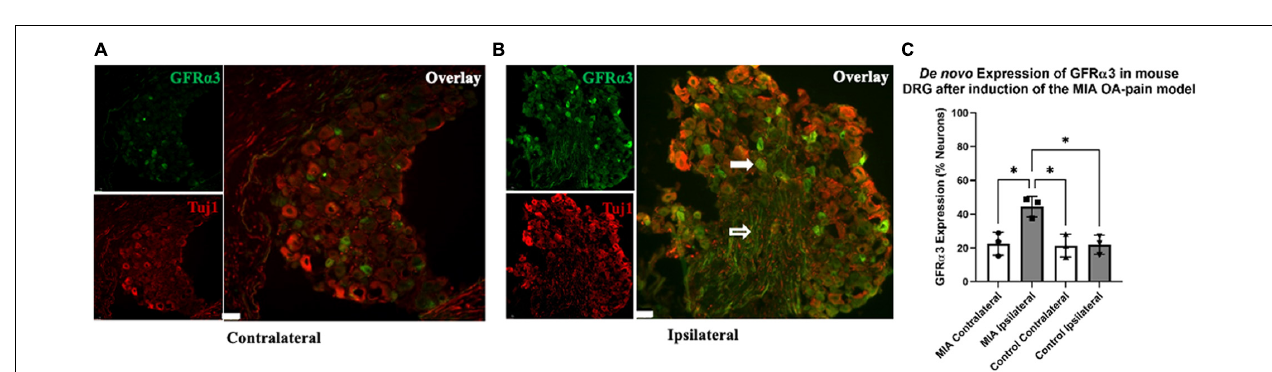
FIGURE 3 | Monoiodoacetate-induced hypersensitivity in Trpv1 KO mice. Mechanical (A) , heat (B) , and cold (C) sensitivity were measured at baseline and over 28 days following MIA induction of OA-pain in wild-type (WT) and Trpv1 knockout (KO) mice. (A,C) There was no statistically significant difference between WT and Trpv1 KO mice at baseline or at any time points post-MIA injection. (B) Trpv1 KO mice had significantly longer withdrawal latencies (decreased sensitivity) to a heat stimulus at baseline, days 3, 14, 21, and 28 post-MIA than WT mice. WT MIA ( n = 5), Trpv1 KO MIA ( n = 4). Data are represented as mean ± SD (* p < 0.05; ** p < 0.01; *** p < 0.001). Two-way ANOVA with repeated measures and Geisser–Greenhouse and Sidak corrections.